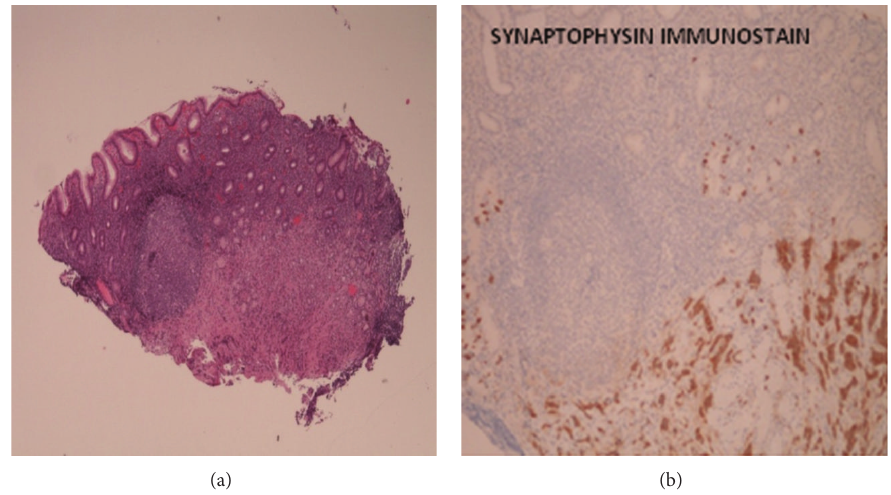
Figure 3: A well-differentiated neuroendocrine tumor consistent with carcinoid seen.